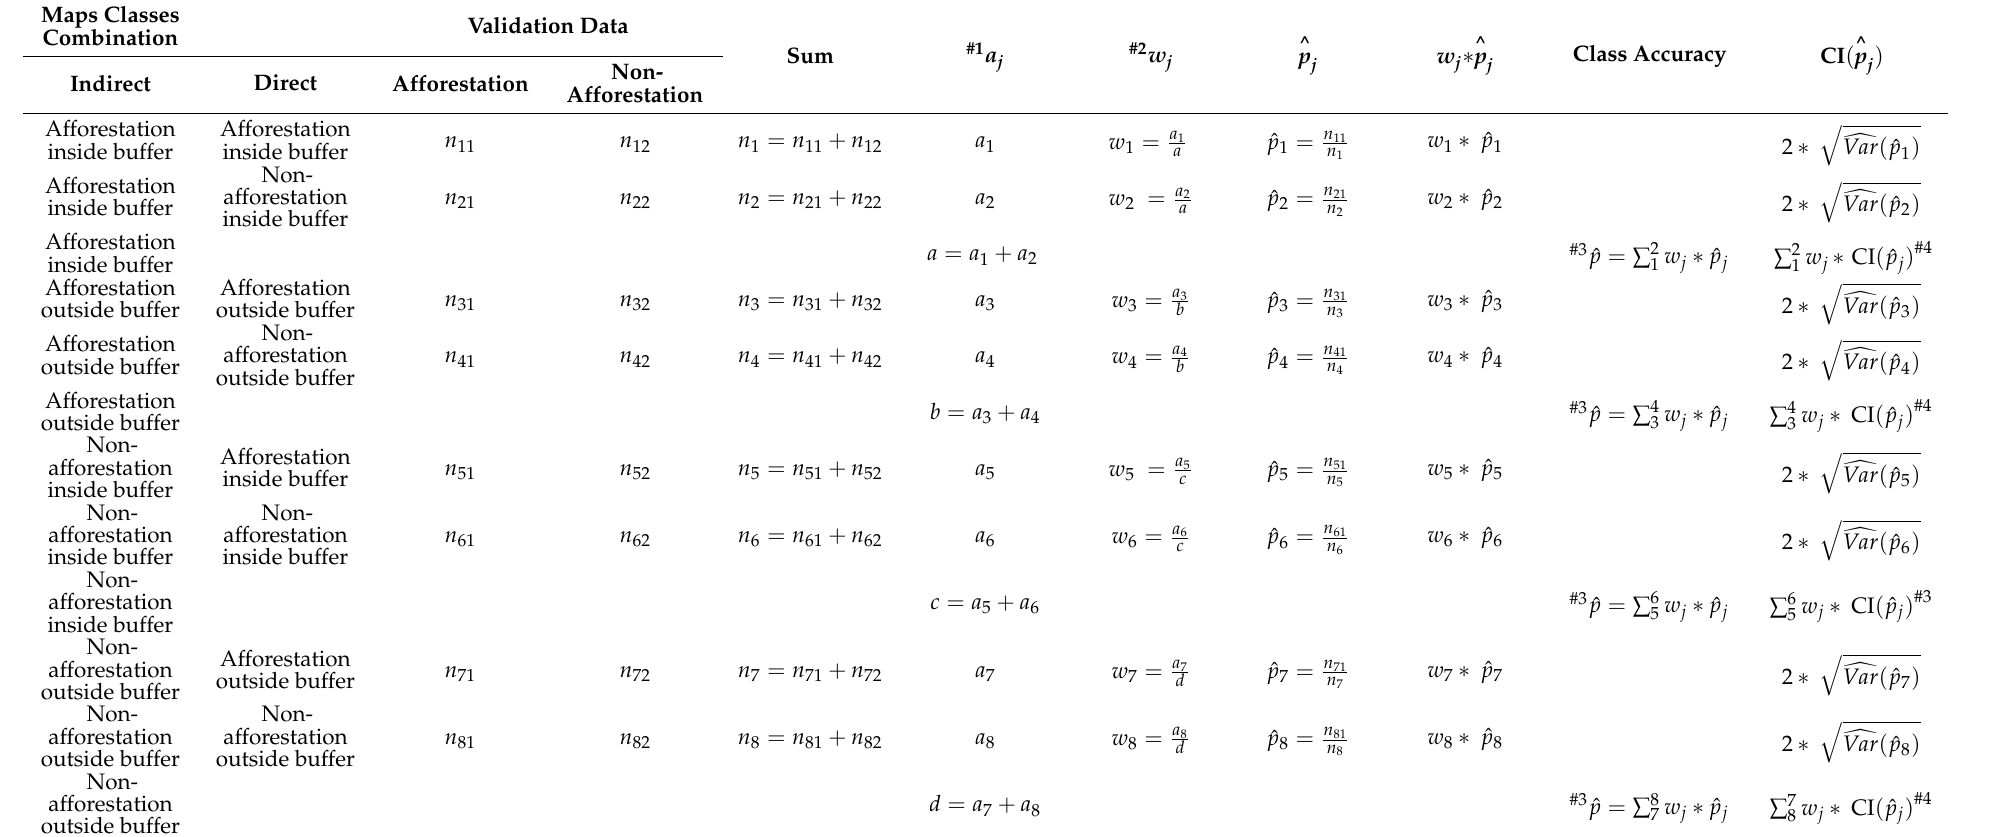
Table 5. Per class accuracy assessment for indirect